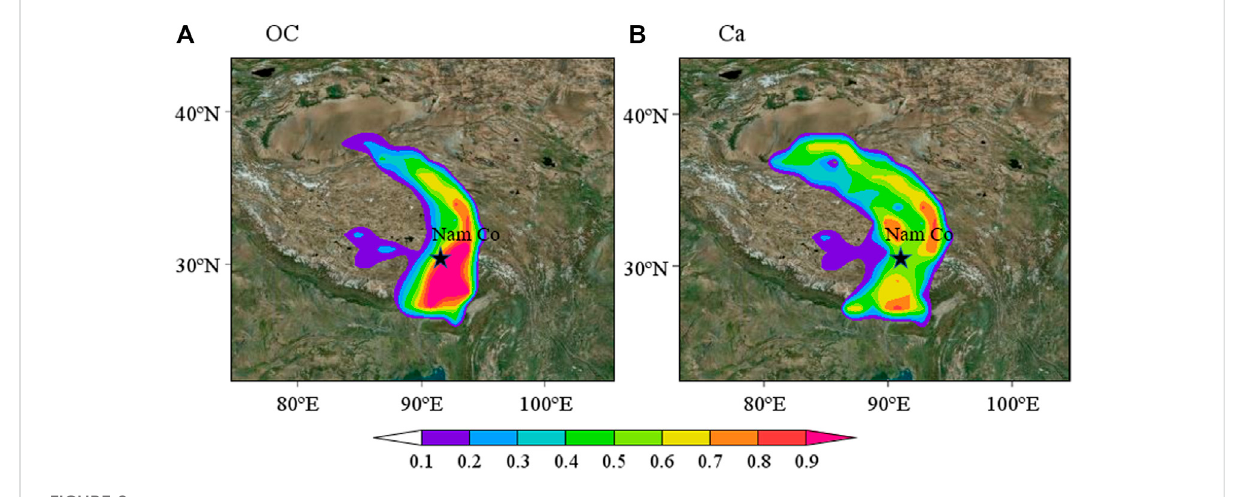
Potential source regions of OC (A) and Ca (B) in aerosols at Nam